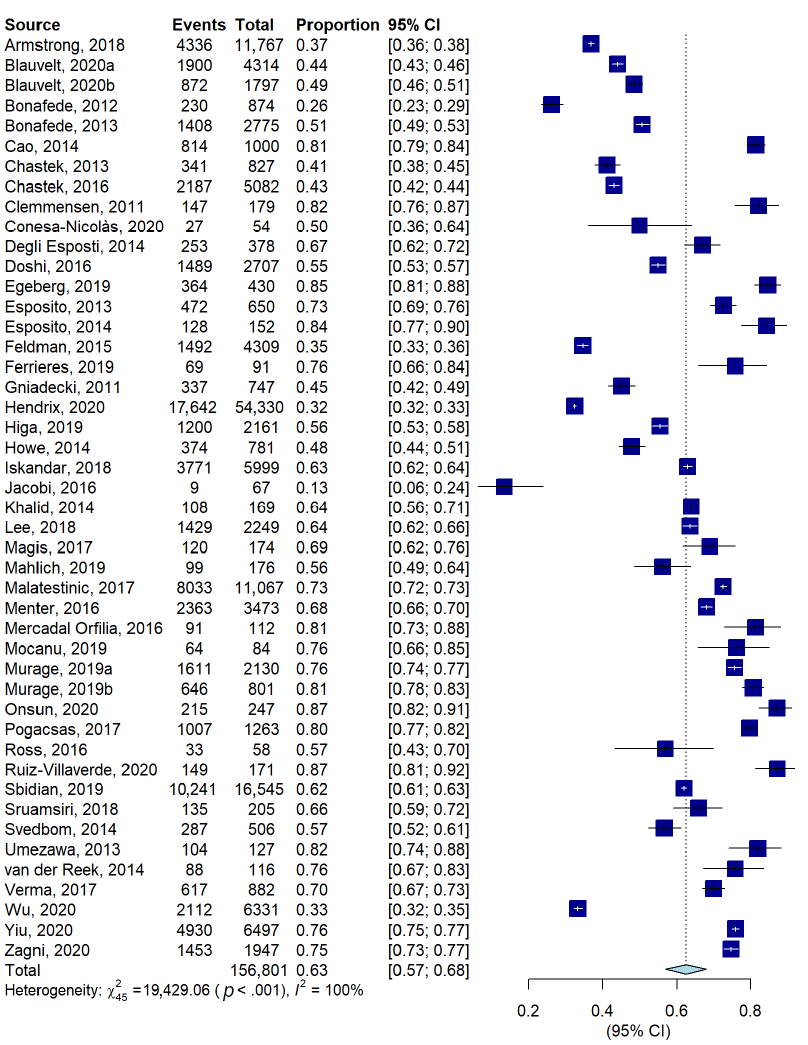
Figure 5. Forest plot of proportions, and their 95% confidence intervals, of persistent patients